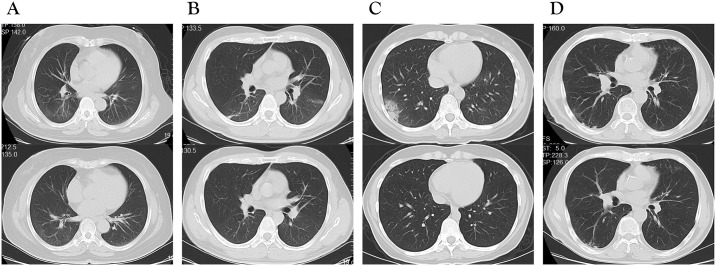
Chest CT images.(A) Transverse chest CT images from a 62-year-old woman who got RP 14 days after discharge, showing multiple inflammation in bilateral lungs at readmission (lower panel), which has partly absorbed compared to the condition at first discharged (upper panel). (B) Transverse chest CT images from a 30-year-old man who got RP 8 days after discharge, showing improved multiple inflammation and decreased shadows of fibrotic streaks at readmission (lower panel) compared to the condition at first discharged (upper panel). (C) Transverse chest CT images from a 32-year-old woman who got RP 6 days after discharge, showing inflammation on bilateral lower lobe at readmission (lower panel), which has partly absorbed compared to the condition at first discharged (upper panel). (D) Transverse chest CT images from a 68-year-old male NRP patient, showing multiple inflammation in bilateral lungs 14 days after admission (lower panel), with no obvious change compared with the condition at admission (upper panel).